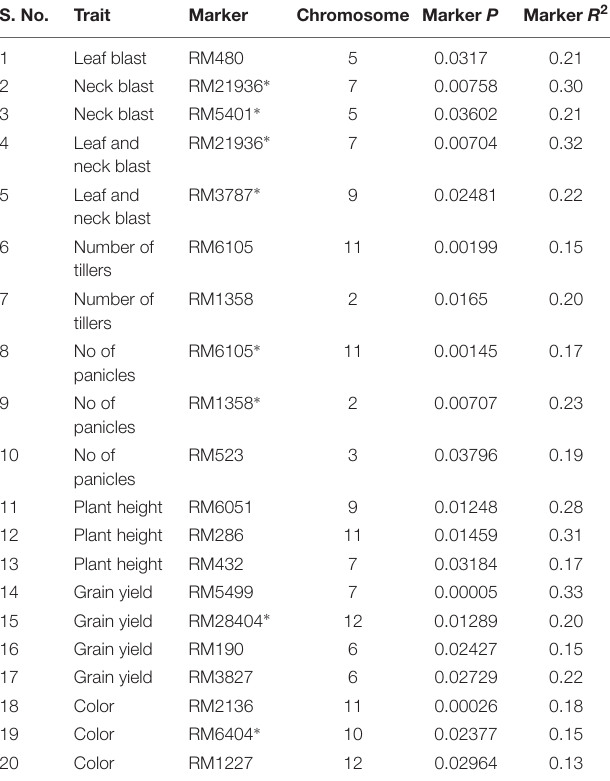
TABLE 2 | Association analysis between agronomic traits and SSR